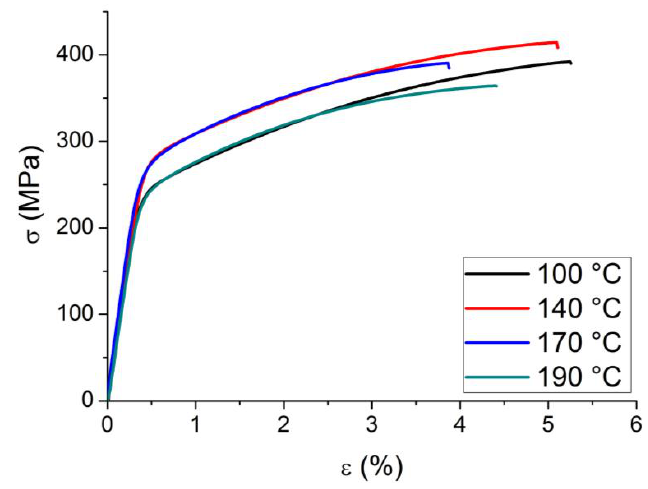
Figure 5. Stress–strain curves of A357 samples.